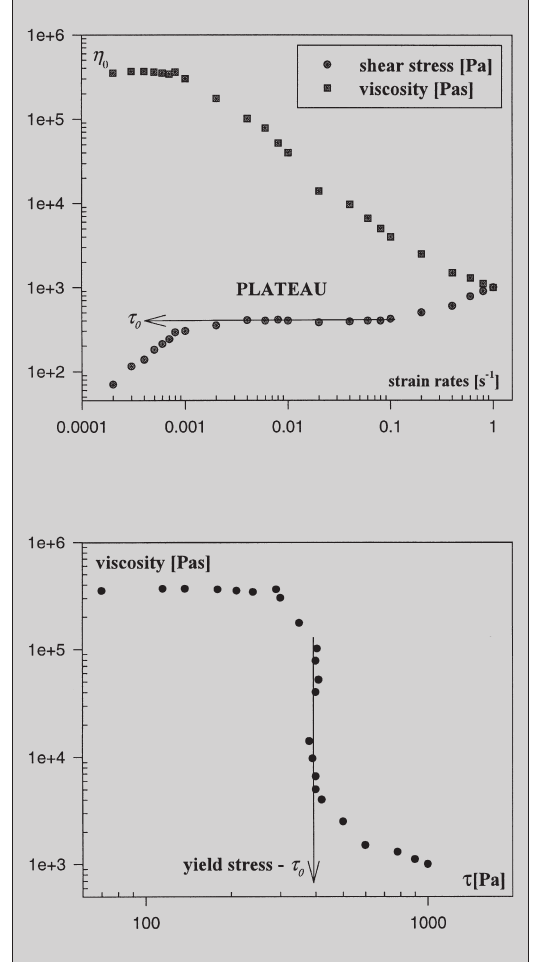
Figure 1 (left): Steady flow curve and the viscosity function of fluids with yield stress (P&G cos- metic cream; controlled stress and controlled strain experiments).